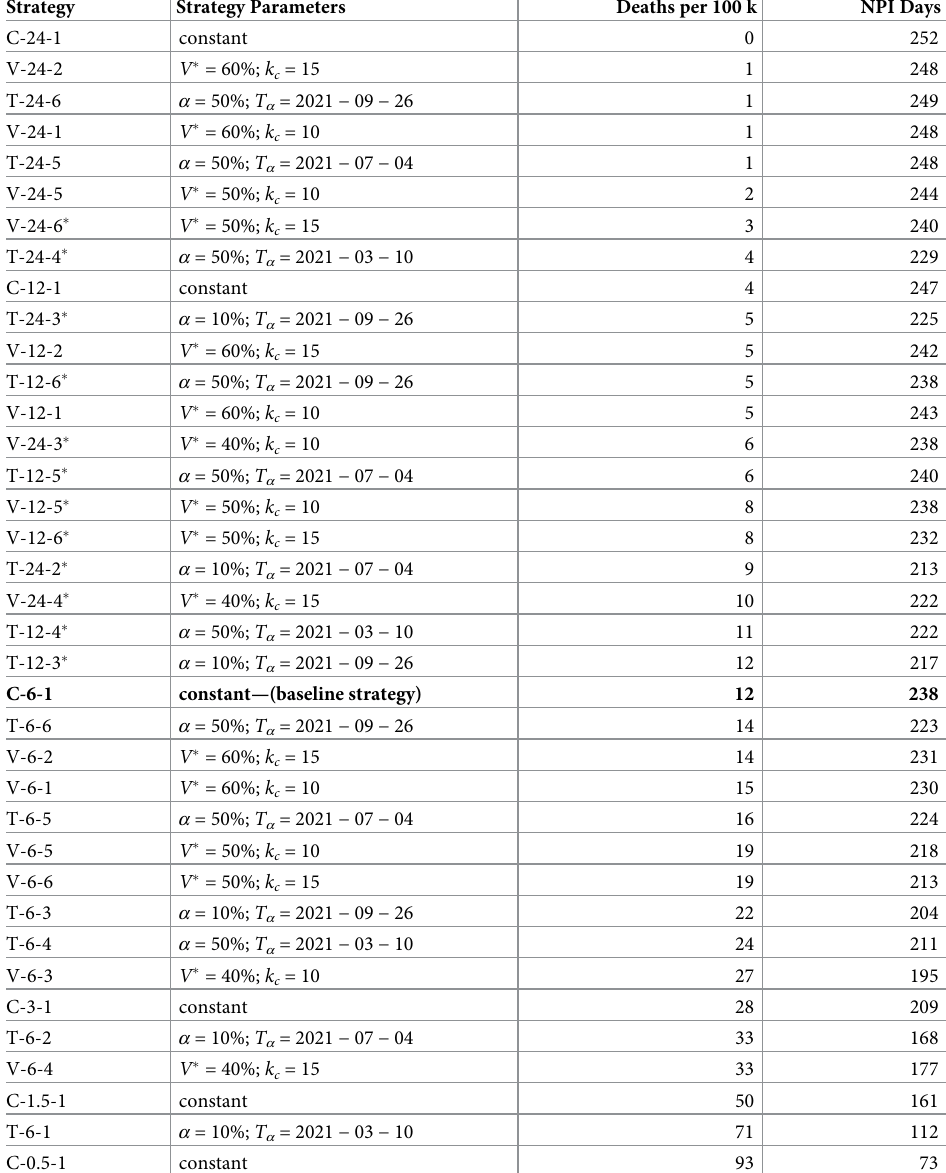
Table 1. Regret percentiles by metric and strategy for a set of non-dominated and constant-caution